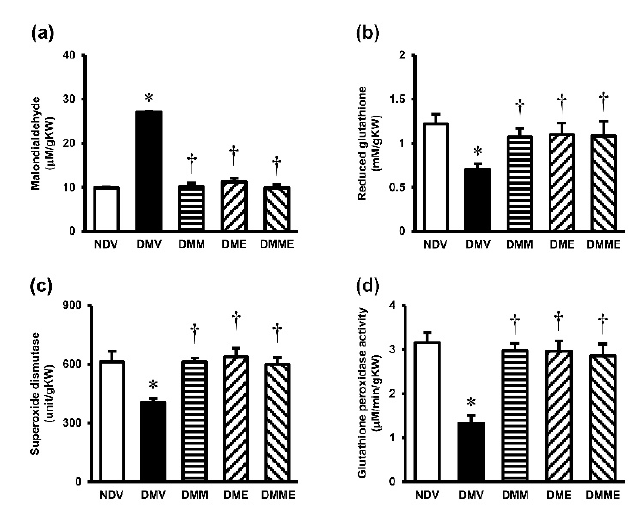
Figure 4. Effects of purple rice husk extract (PRHE) and metformin on renal oxidative stress indexes. ( a ) malondialdehyde; ( b ) reduced glutathione; ( c ) superoxide dismutase; ( d ) glutathione peroxidase. Values are the mean ± SD ( n = 6). NDV: vehicle-treated normal group; DMV: vehicle-treated diabetic group; DMM: metformin-treated diabetic group; DME: PRHE-treated diabetic group; DMME: metformin plus PRHE-treated diabetic group; KW: kidney weight. * p < 0.05 vs. NDV, † p < 0.05 vs. DMV.